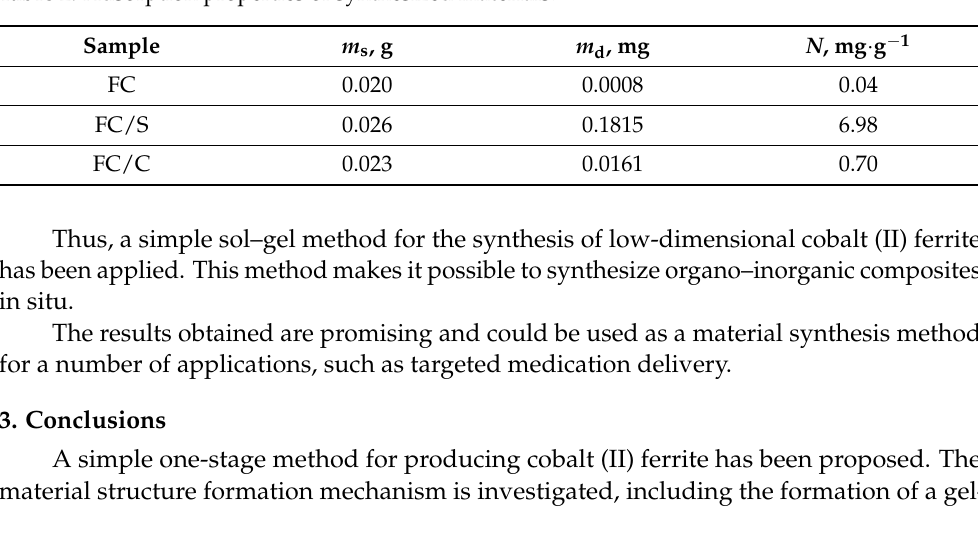
Table 2. Adsorption properties of synthesized